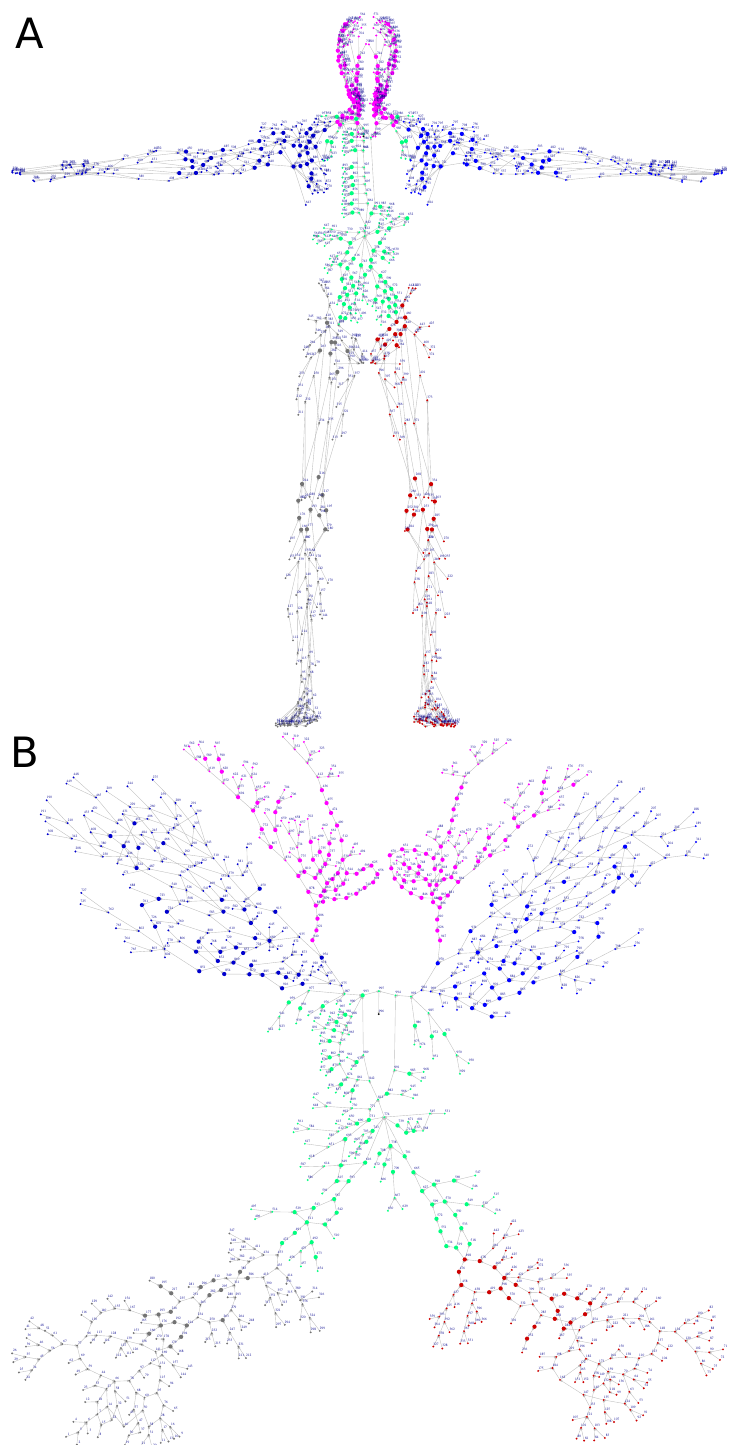
Figure 5. Oriented graph model of the HLS based on the analysis of the lymph flow directions in the network. ( A ) Spatial view of the graph with numbered vertices (face-view projection of 3D coordinates). ( B ) View of the graph on a plane with no-overlapping layout. The 2D layout was obtained using spring-based model algorithm [19] implemented in package igraph , followed by some manual tweaking to space out the vertices. The colored subgraphs correspond to different parts of the body, i.e., arms (dark and light blue), head/neck (magenta), torso (light green), legs (red and gray). LNs are represented by larger